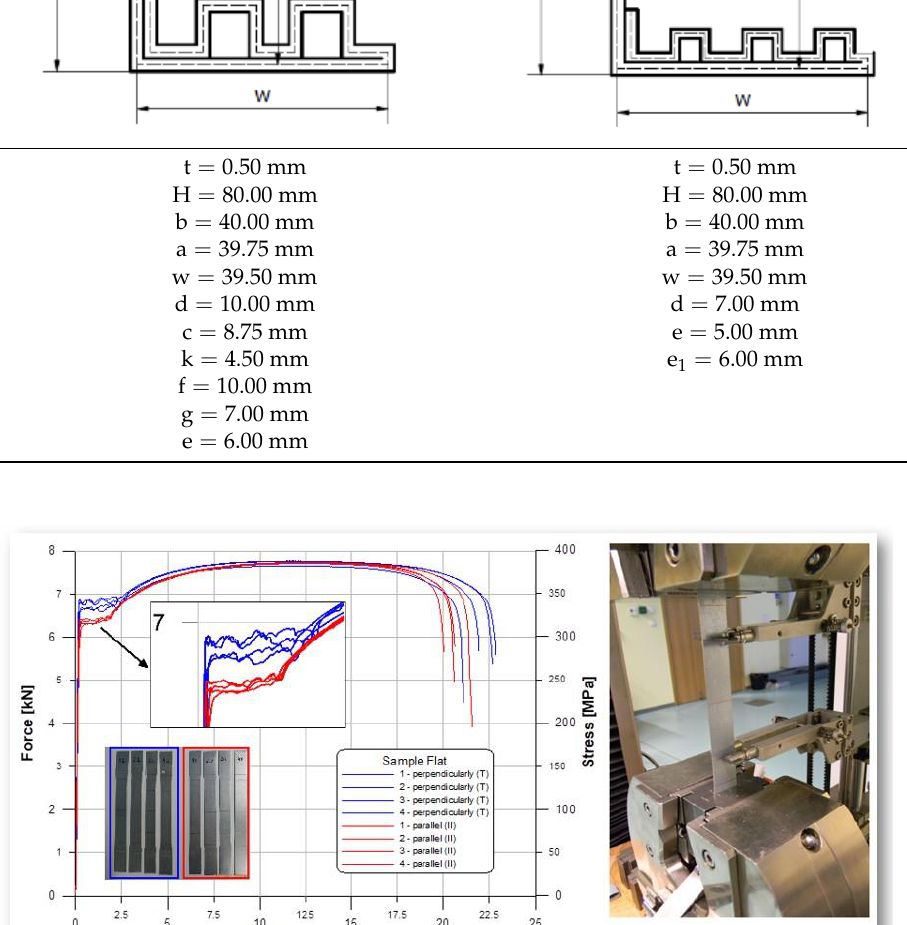
Table 3. Geometric characteristics of cross-sections